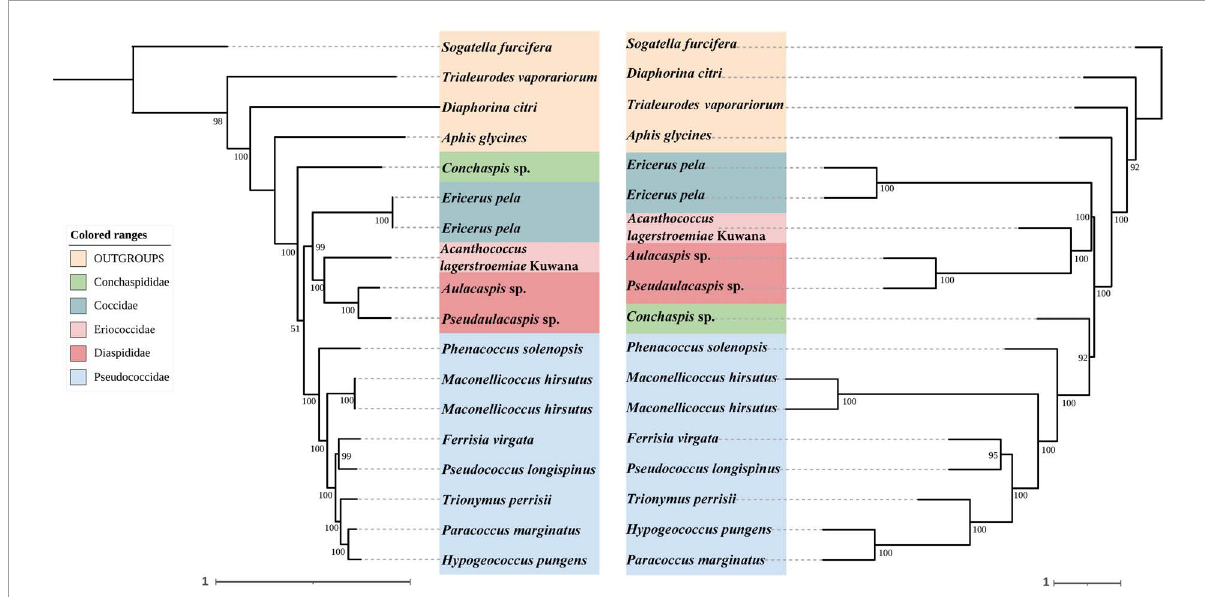
FIGURE7 Left: Concatenated tree of 95% completeness matrices from Hemiptera probe set. Node values are bootstrap support. Right: Species tree of 95% completeness matrices from Hemiptera probe set. Node values are bootstrap